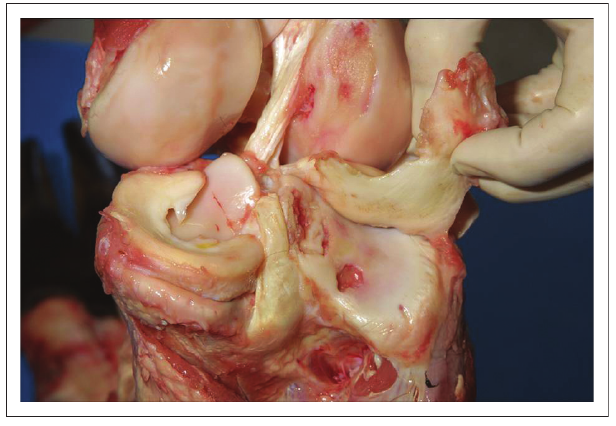
Source : Photo taken by Leon Prozesky FIGURE 4: Severe degenerative chondral lesions extending to the menisci.